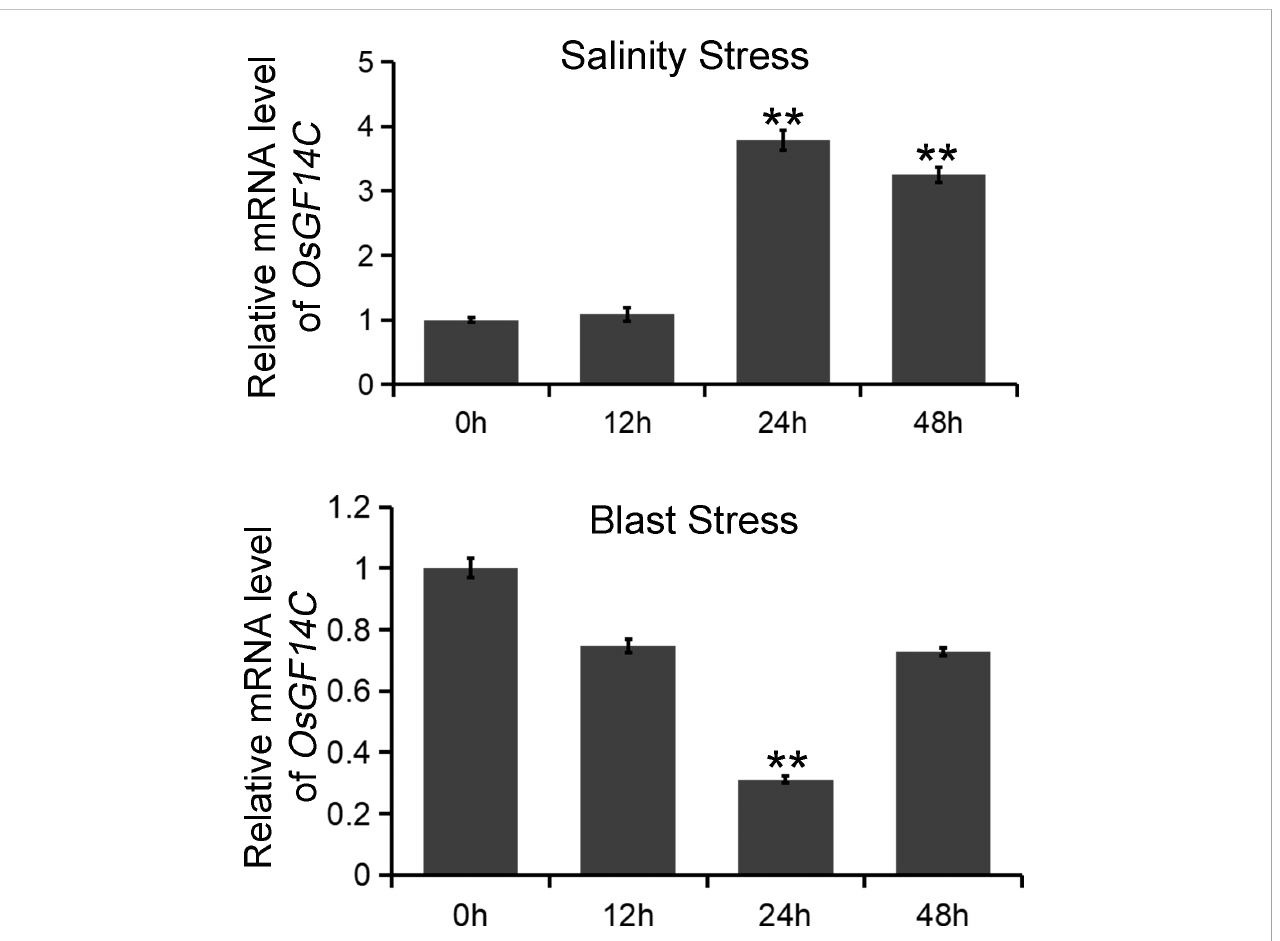
FIGURE 1 The expression patterns of OsGF14C in responses to salinity stress and blast stress, respectively. The expression of OsGF14C during salinity stress and blast stress as assessed by quantitative real-time PCR at 0 h before treatment and 12 h, 24 h, 48 h after treatment. Error bars indicate the standard deviation (SD) from three biological replicates and ** indicates a statistically signi fi cant difference compared with 0 h treatment ( t test, p